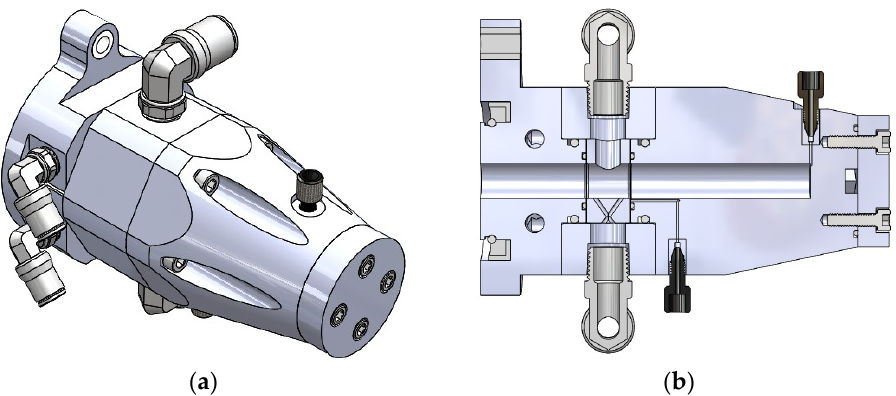
Figure 6. BN-124 target: ( a ) Isometric and ( b ) vertical mid-plane cross-section views.